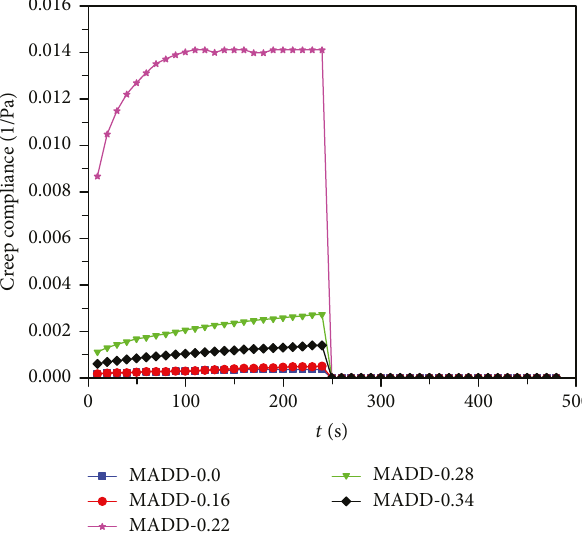
Figure 11: Curves of creep recovery at 45.0 ± 0.1 °